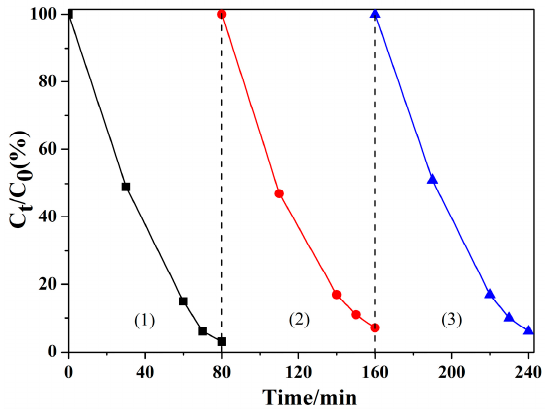
Figure 7. MO degradation during a series of three tests with additional 5 mg L − 1 MO at 80 min intervals. The initial conditions: MO 5 mg L − 1 , Na 2 SO 4 1 M L − 1 , applied 1.5 V vs. CE and pH = 2.